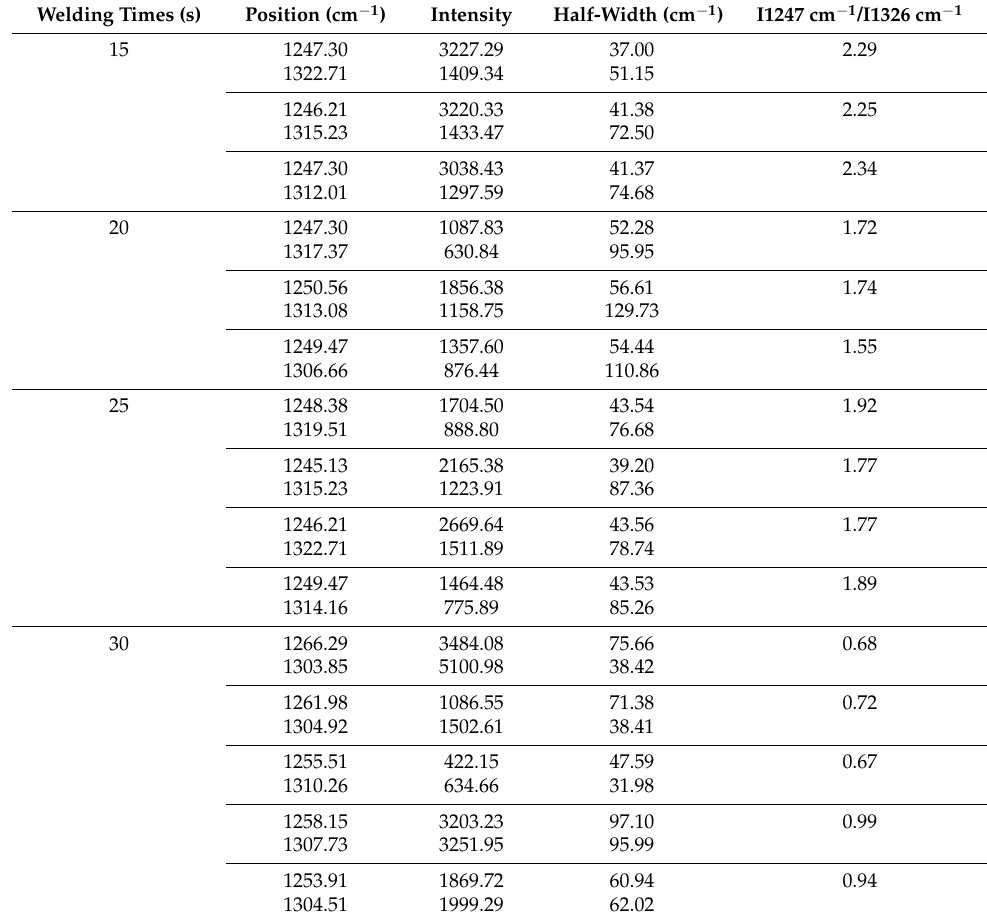
Figure 8. ( a ): Raman spectrum data of vessel tissue with different welding times; ( b ): Density rate of I1247 cm − 1 and I1325 cm − 1 . Scattering points on the left side of the box are specific sample data points. Y -axis coordinates only represent the Raman intensity of “15 s”. We vertically shift the Raman spectrum image of “20 s”,”25 s”and”30 s” in the Y -axis direction to different degrees, in order to compare the differences between them conveniently. Table 4. Raman Spectrum